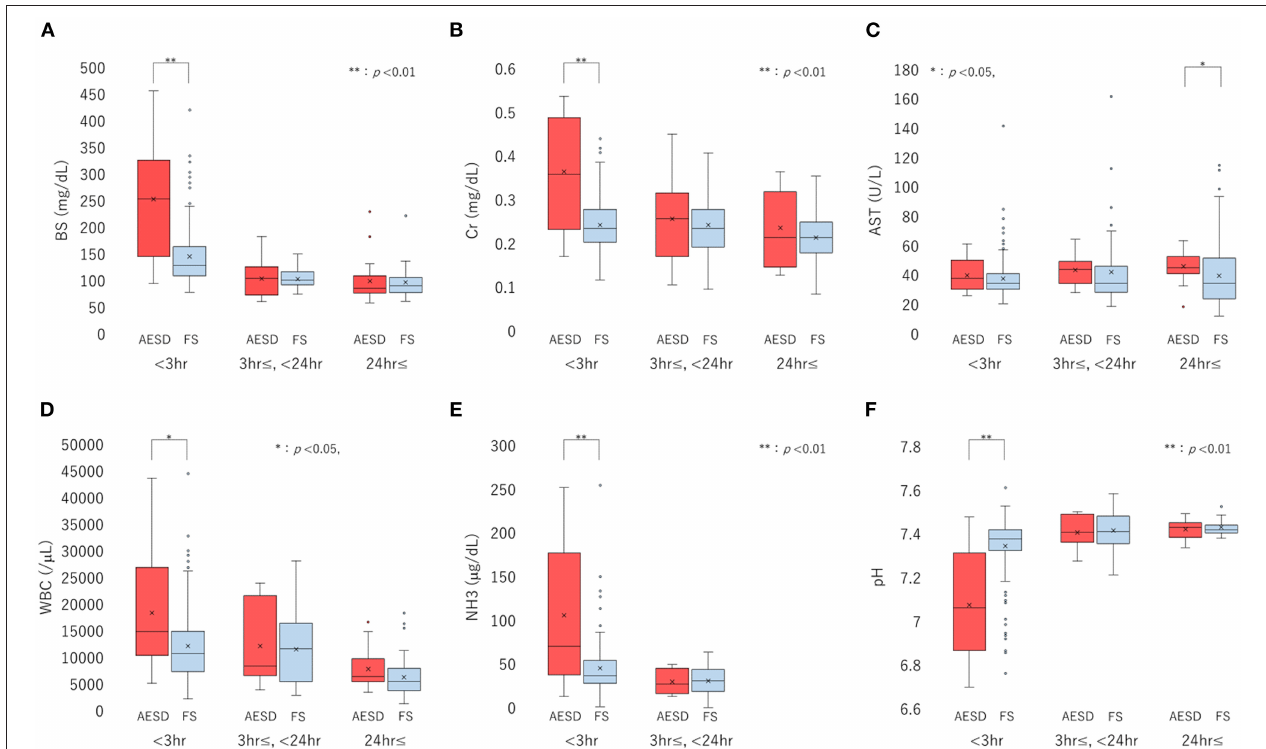
FIGURE 2 | Boxplots of laboratory data, including the levels of blood sugar (BS) (A) , serum creatinine (Cr) (B) , and aspartate aminotransferase (AST) (C) , white blood cell (WBC) count (D) , ammonia (NH3) level (E) , and pH (F) , divided into three sampling-time periods from onset: < 3h, 3h to < 24h, and ≥ 24h. Each box, horizontal line in box, and cross mark indicates the interquartile range (IQR), median, and mean, respectively. Whiskers denote the range between 1.5 times the IQR upper from the third quartile and lower from the first quartile, and circles indicate outliers. The distributions of laboratory data are compared between biphasic seizures and late reduced diffusion (acute encephalopathy with biphasic seizures and late reduced diffusion [AESD]) and febrile seizure (FS) at each period, using the Mann-Whitney U test. BS (A) and Cr (B) levels, WBC count (D) , and NH3 level (E) are significantly higher in AESD than FS at < 3h, and pH (F) was significantly lower in AESD than FS at < 3h. AESD patients showed a significant increase in AST level (C) at ≥